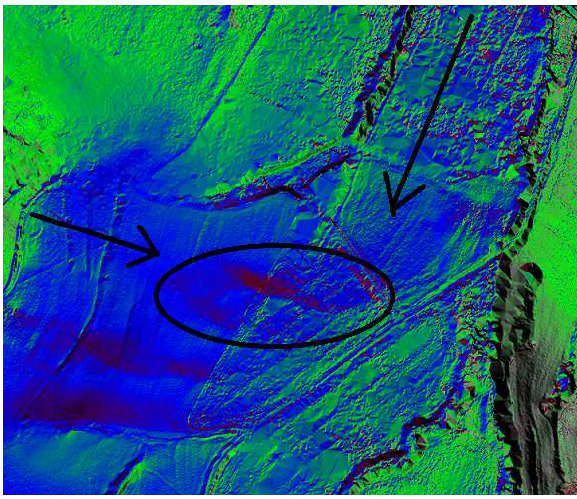
Figure 3. Aspect image - branches of a pathway crossing hillside (slope image) Besides, some authors have presented other visualization methods such as sky-view factor (Zakšek et al., 2011), aspect or slope images, etc. Dušánek (2011) presented color composed shaded relief which is a combination of three shaded relief images (red, green and blue color) illuminated from azimuths 315°, 195° and 75°. A review of DTM visualization methods used in archaeology was offered by Bennett et al.